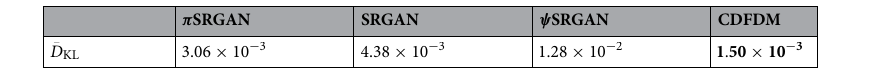
Table 3. Average KL divergence of PDFs. Significant values are in